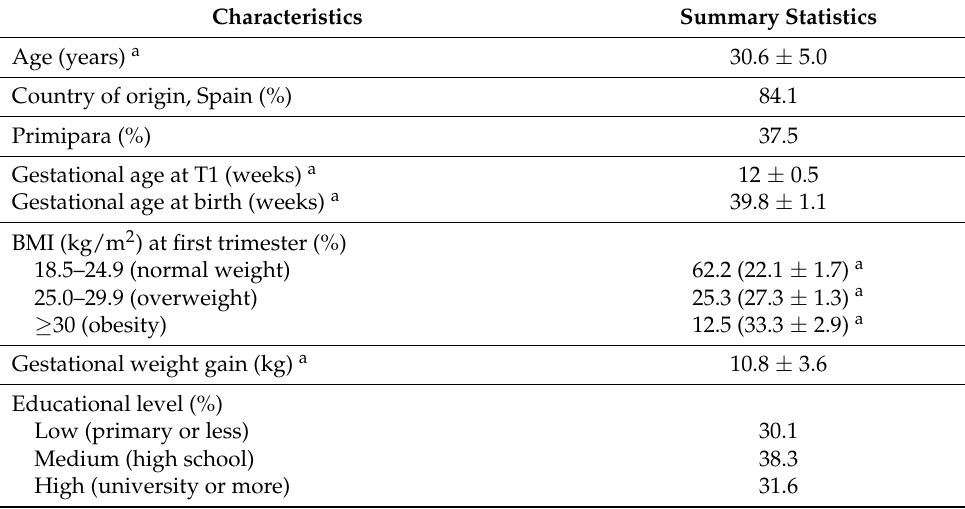
Table 1. Sociodemographic and lifestyle characteristics of pregnant women ( n =